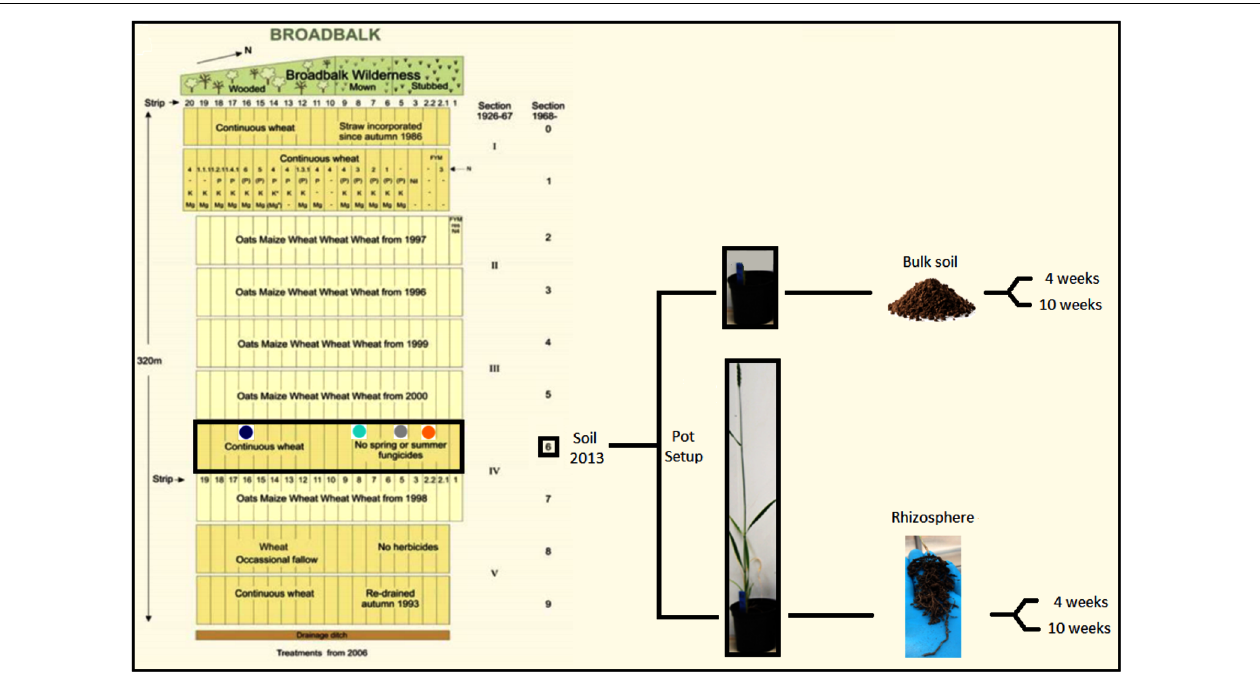
FIGURE 1 | Schematic representation of the experimental setup. Soil samples were collected from the Broadbalk experiment (section 6) in 2013 from strips under different fertilization regime [2.2 = organic N (orange); 5 = zero N (gray); 8 = medium inorganic N (turquoise); 16 = high inorganic N (dark blue)]. Soil was used to grow Triticum aestivum cv. Cadenza in pots. Bulk soil and rhizosphere samples were collected after 4 and 10 weeks. Modified from Rothamsted Research (2006).